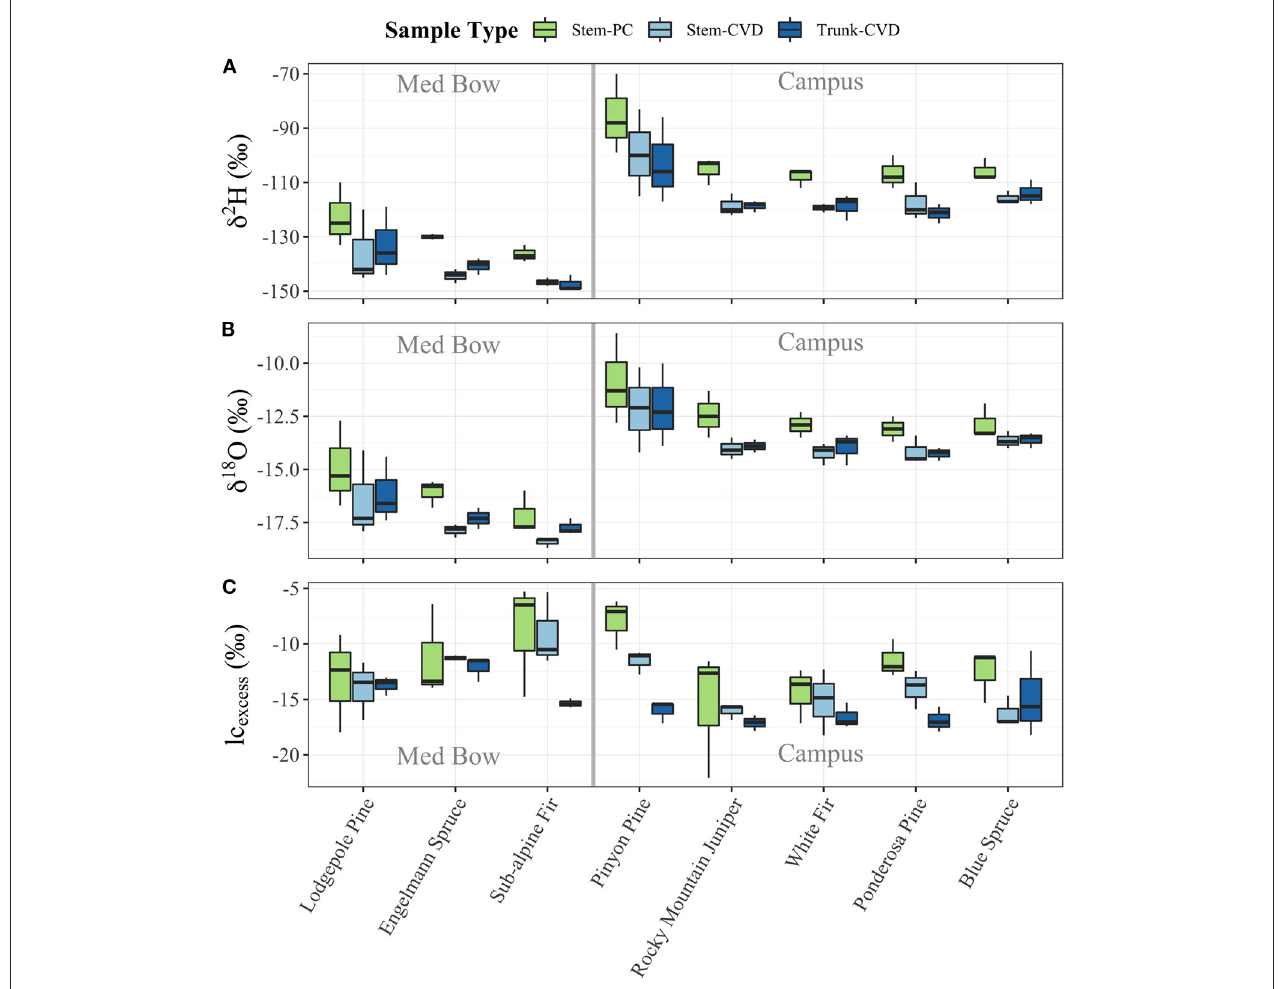
FIGURE 4 | Boxplots of plant water stable isotope data separated by sample type and species: (A) δ 2 H, (B) δ 18 O, and (C) lc-excess. Gray bars in center of plots help visually separate samples by location.